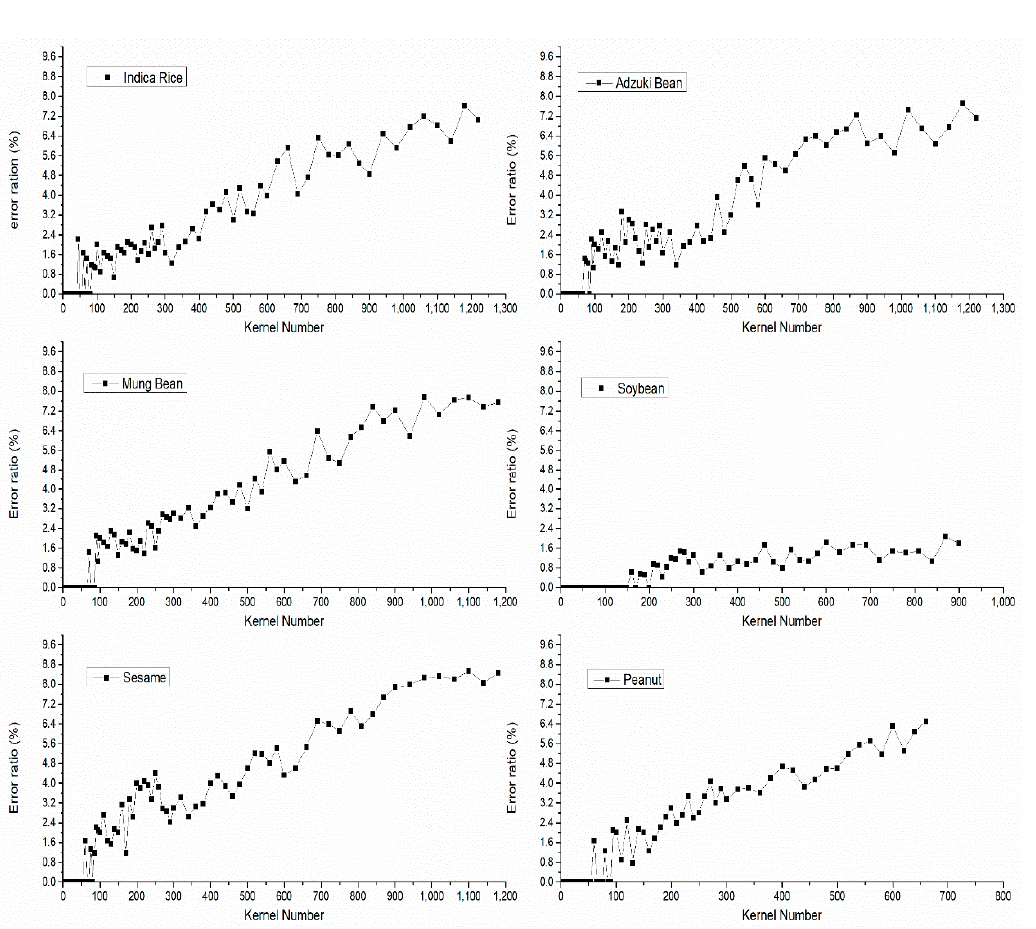
Figure 9. The relationship between error ratios and kernel number. Table 3. The average TKW (thousand kernel weight) parameters of different species of kernels.